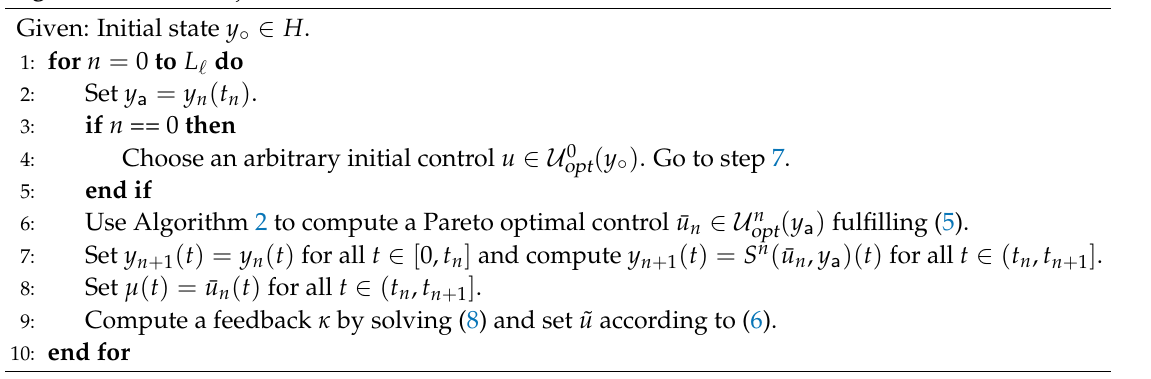
Algorithm 3 Multiobjective Model Predictive